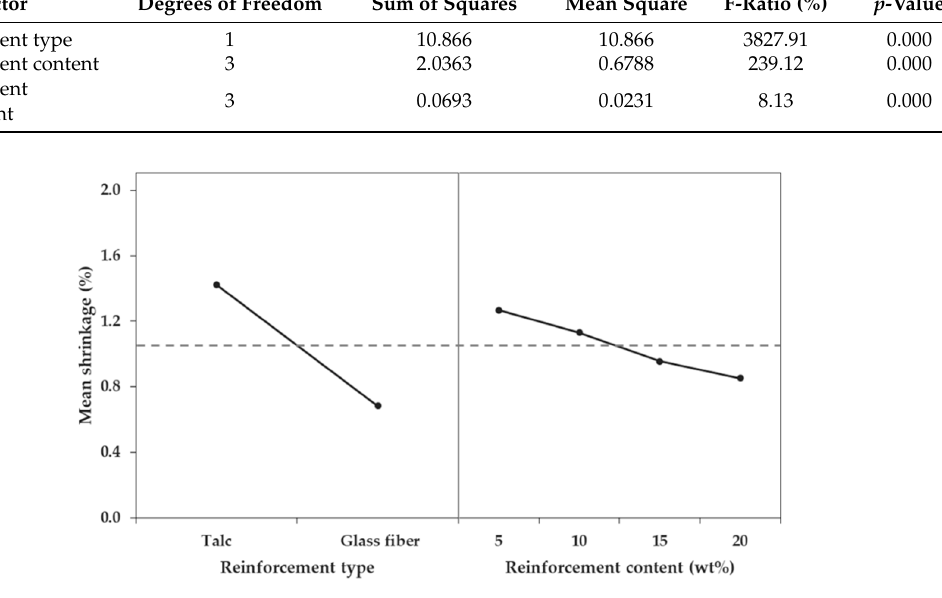
Figure 14. Main effect plot for shrinkage in the flow direction. Table 7. Two-way ANOVA for shrinkage in the transverse direction.